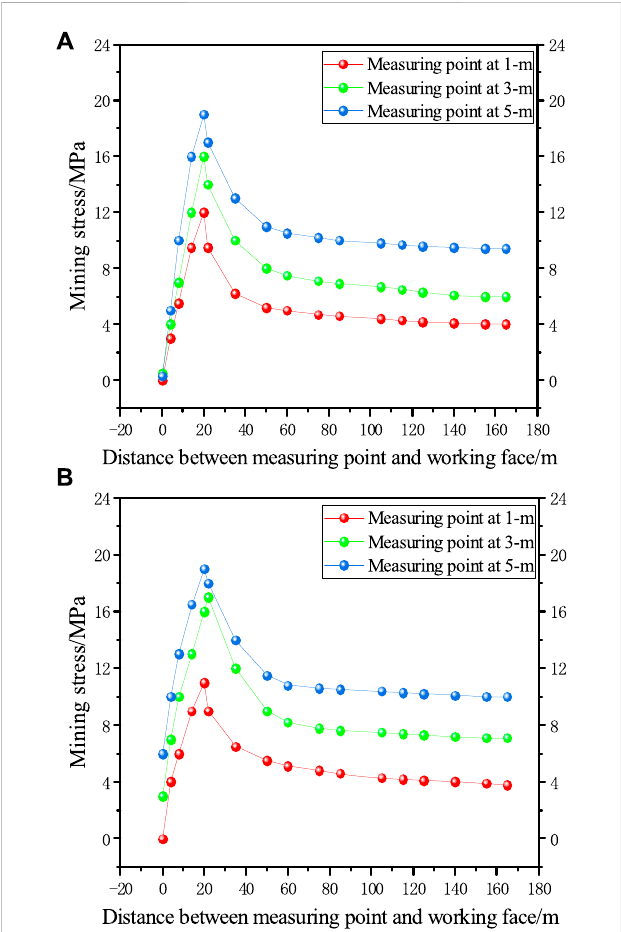
FIGURE 20 Vertical mining-stress curves of each measuring point in the track roadway of the fi rst measuring station. (A) Upper side of the track roadway. (B) Lower side of the track